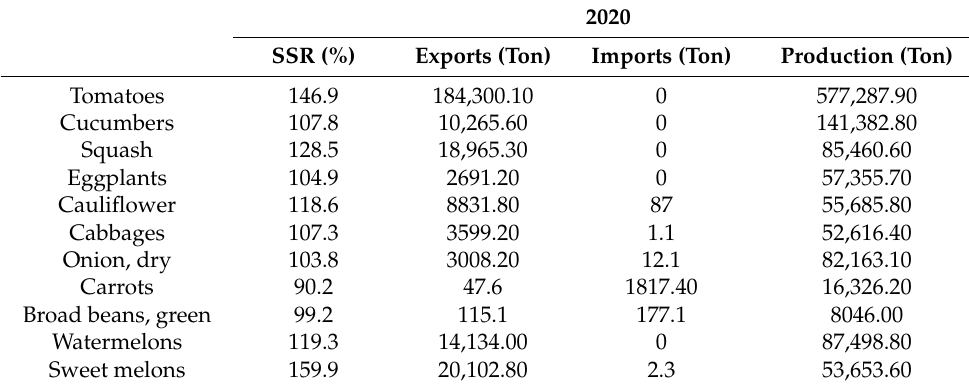
Table 2. Self-sufficiency ratio (SSR) of vegetables (2020) [34].